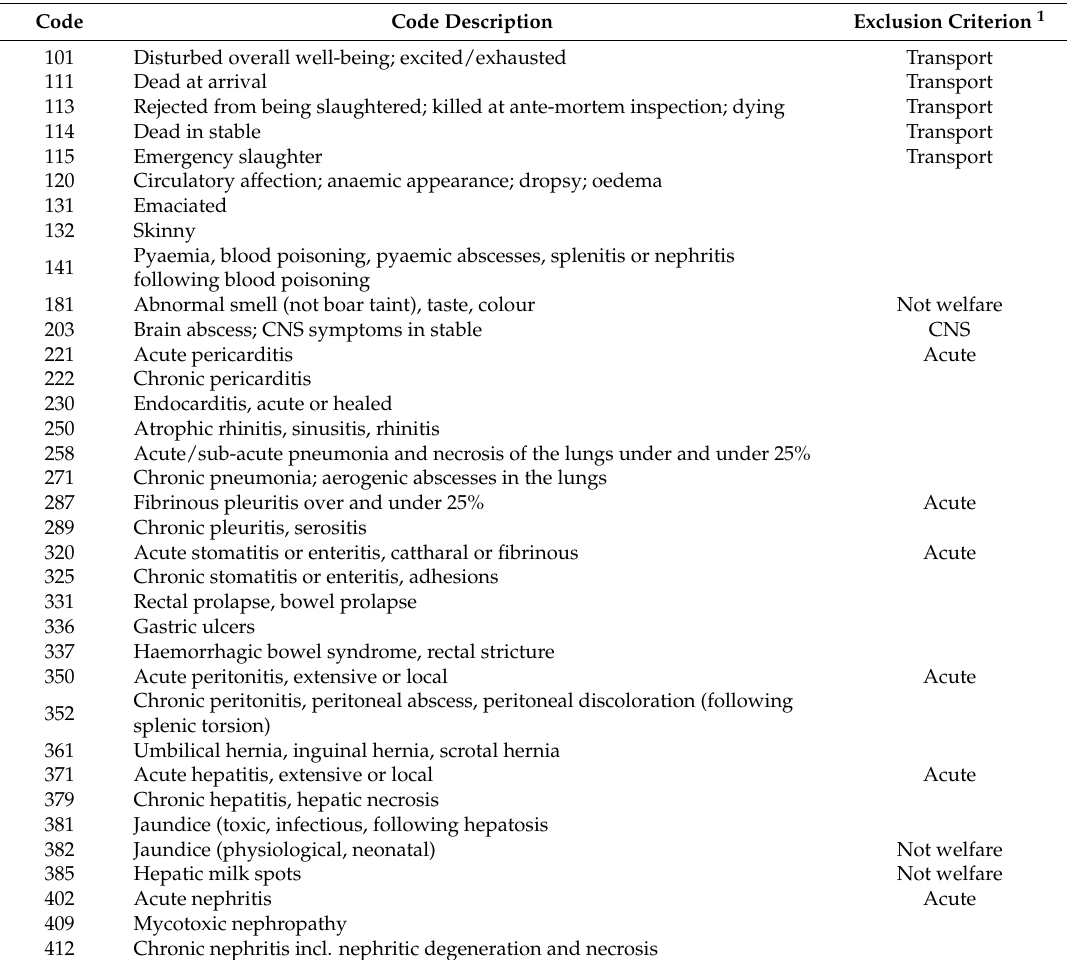
Table A1. Descriptions of pig meat inspection codes (translated from Ministerial circular 9611 [8]) including exclusion criterion for excluded